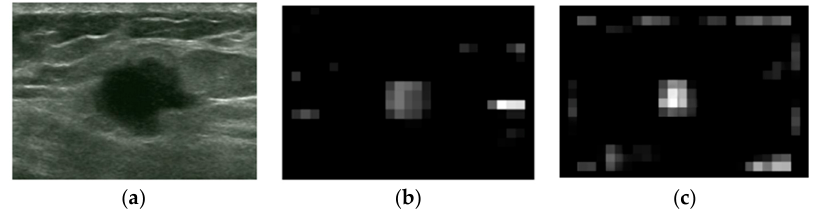
Figure 3. Saliency maps of intensity and blackness ratio features: ( a ) Original image. ( b ) Intensity saliency map. ( c ) Blackness ratio saliency map.